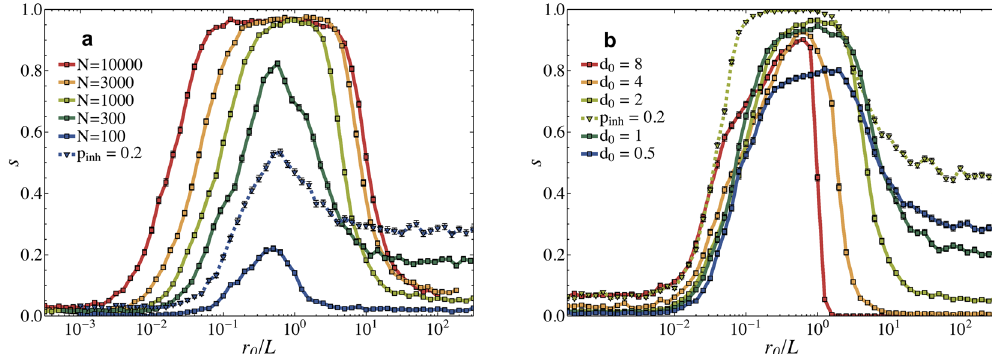
Figure 4. System size dependence and influence of the synaptic length. ( a ) The success rate s as a function of r 0 / L for different network sizes N ( T max = 10000, d 0 = 2, t refr = 1, first ten patterns of Table 1). Larger networks show a better performance and the peak of the performance roughly moves proportionally to L . ( b ) The effect of the network structure is analyzed by plotting s for different synaptic characteristic length d 0 ( N = 1000, T max = 10000, t refr = 1, first ten patterns of Table 1). For N = 100 (in Fig. a ) and for d 0 = 2 (in Fig. b ) we also performed simulations with inhibitory neurons p inh = 0.2 resulting in an overall performance improvement. The error bars represent a 95% confidence interval.